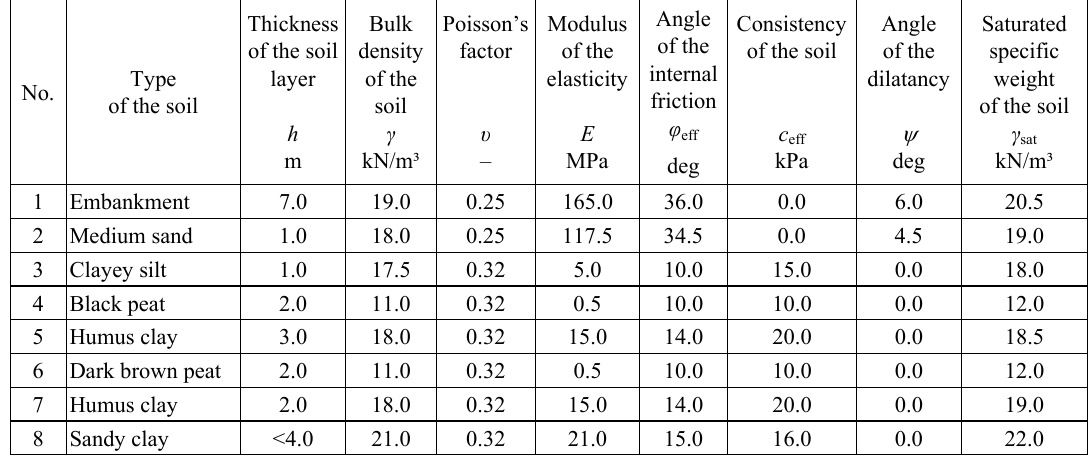
Table 1. Subsoil parameters taken into account for numerical